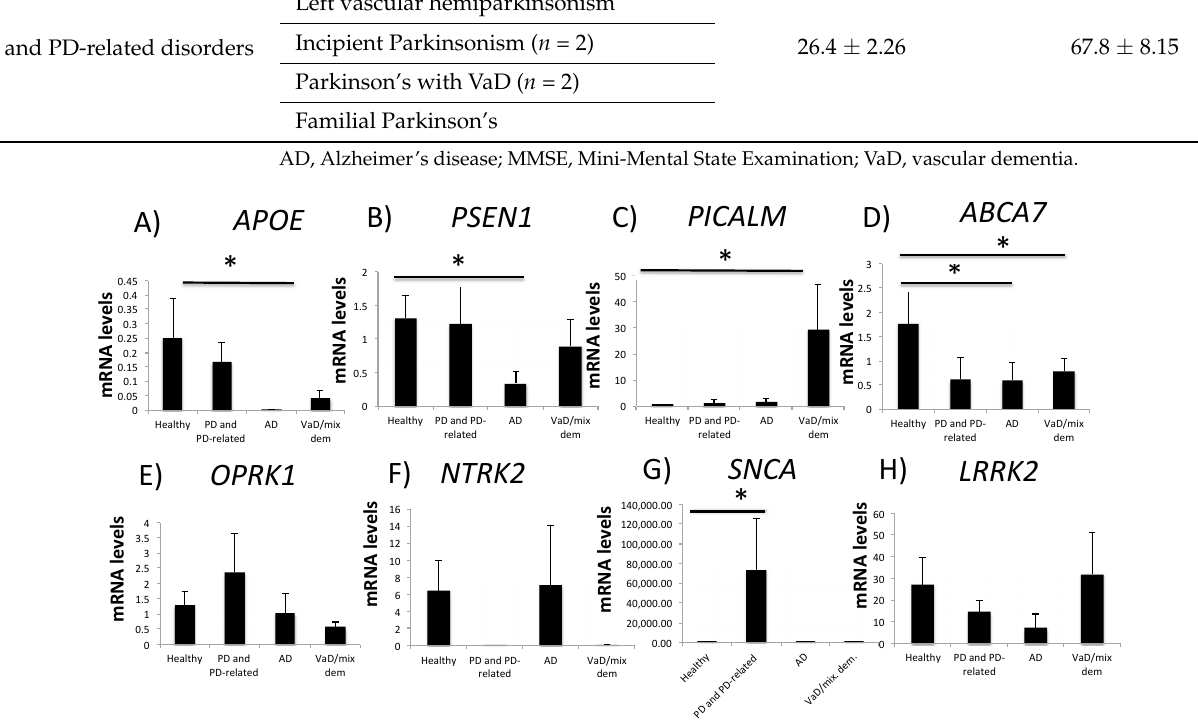
Figure 1. Gene expression in blood (buffy coat) samples from healthy subjects and patients with NDDs. Gene expression was analyzed in buffy coat samples from individuals with no-NDDs ( n = 9) and patients with AD ( n = 7), PD and PD-related disorders ( n = 14), and VaD/mixed dementia ( n = 13). qPCR with TaqMan probes for ( A ) APOE , ( B ) PSEN1 , ( C ) PICALM , ( D ) ABCA7 , ( E ) OPRK1 , ( F ) NTRK2 , ( G ) SNCA and ( H ) LRRK2 were used. One-way ANOVA with post hoc Bonferroni corrections (* p < 0.05). Data are presented as means ± S.E.M. NDD, neurodegenerative disorders; AD, Alzheimer’s disease; ABCA7, ATP-binding cassette, subfamily A, member 7; APOE, apolipoprotein E; PD, Parkinson’s disease; PICALM, phosphatidylinositol-binding clathrin protein; PSEN1, presenilin-1; qPCR, quantitative real-time PCR; SNCA, alpha synuclein; VaD, vascular